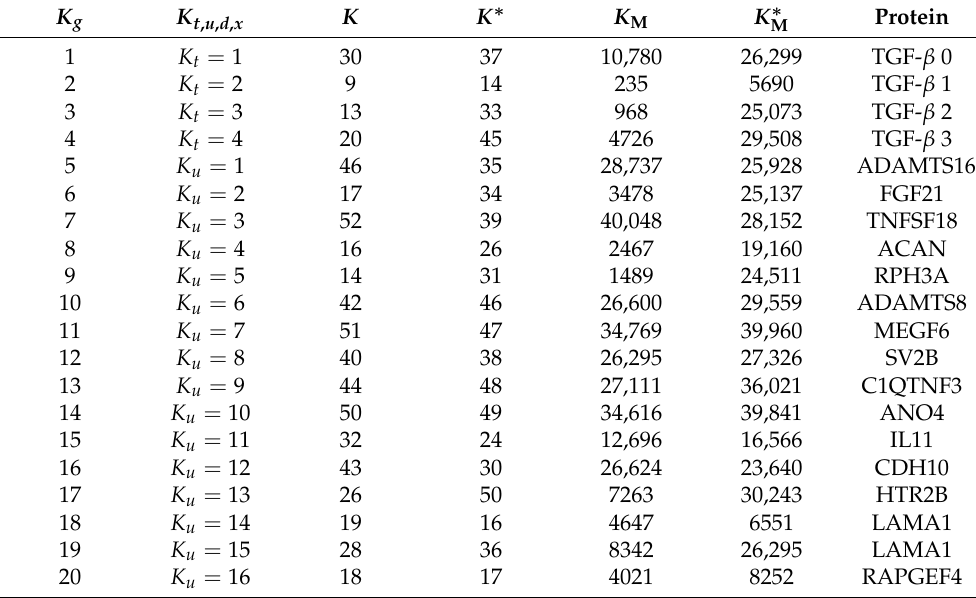
Table 1. Table of the subset of N r = 54 selected fibrosis proteins (nodes). Here, K g represents the global index of this group, K t , u , d , x represent the index of the four subgroups of 4 TFG- β proteins, 20 up-proteins, 20 down-proteins and 10 additional X-proteins; K ( K ∗ ) represents the local PageRank (CheiRank) index obtained from the reduced Google matrix G R ( G R ∗ ) for this group of 54 proteins; K M ( K ∗ ) indexes represent the PageRank (CheiRank) index for the global MetaCore network of M N = 40,079 nodes; the last column gives the associated protein names. K g K t , u , d , x